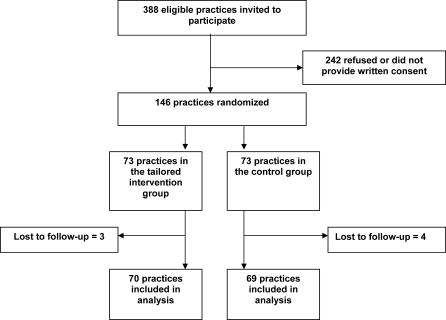
Design of Cluster-Randomized Trial